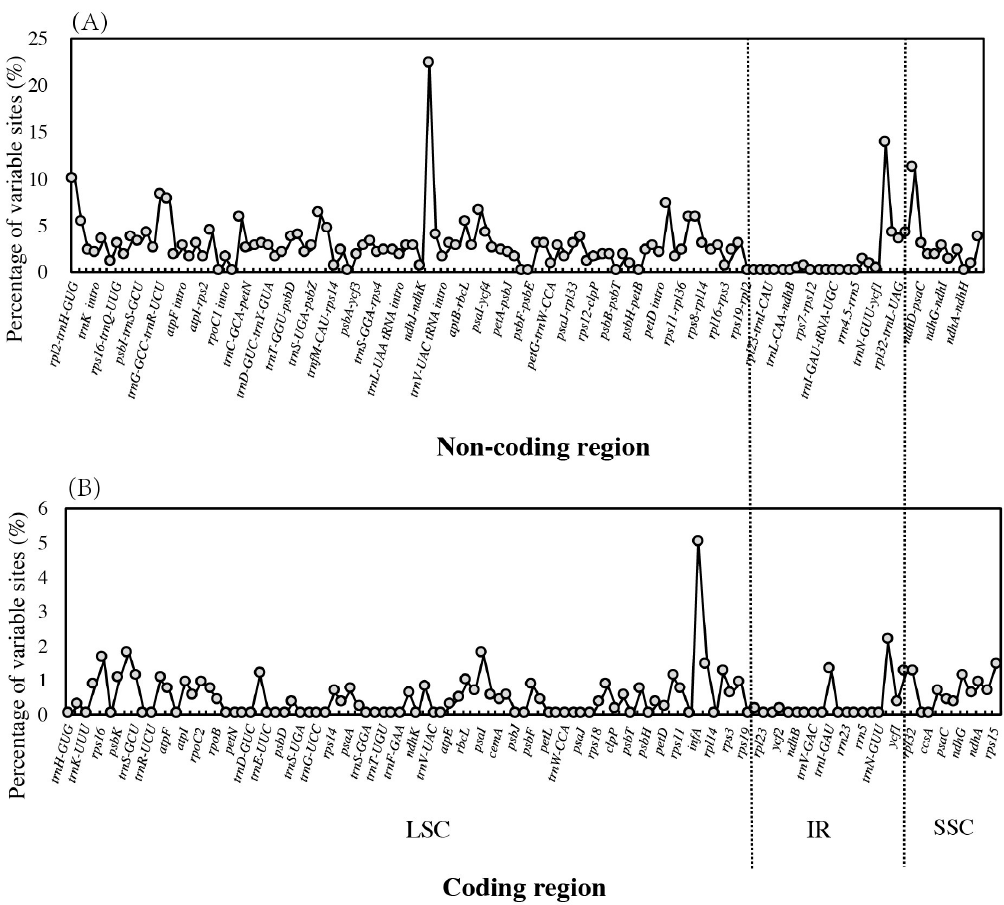
Figure 4. Nucleotide variability (%) values compared among four Ziziphus species. ( A ) non-coding regions; ( B ) coding regions.